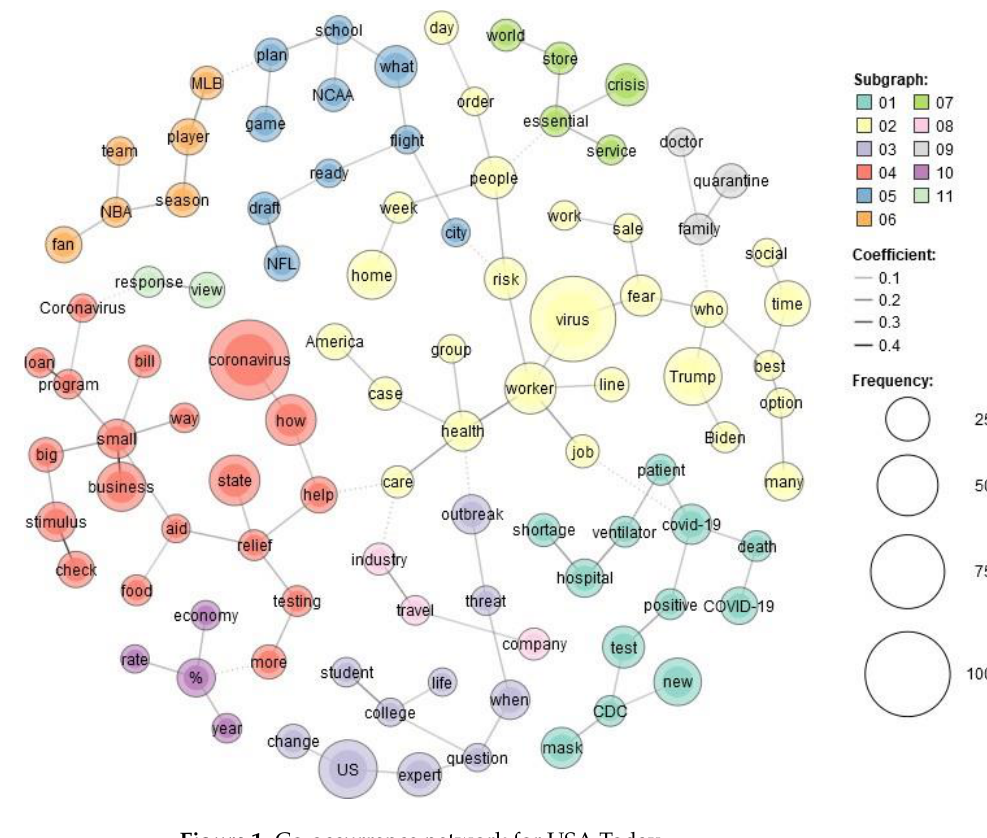
Figure 1. Co-occurrence network for USA Today.